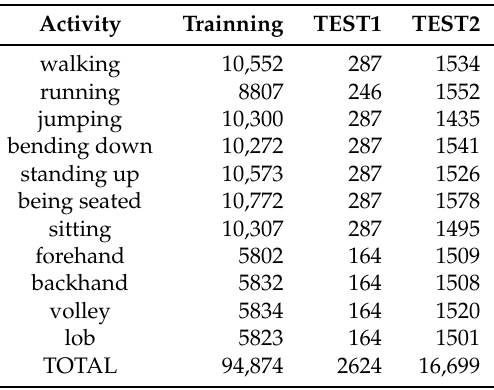
Table 3. Number of spectrograms for training, TEST1 and